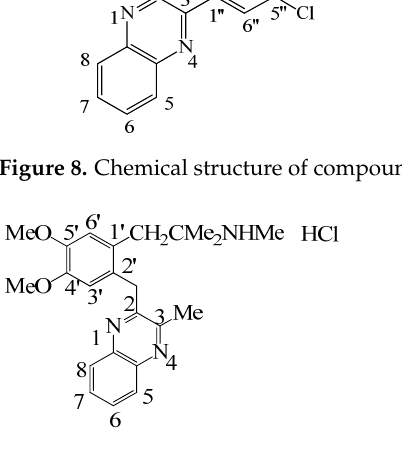
Figure 9. Chemical structure of compound 2f .